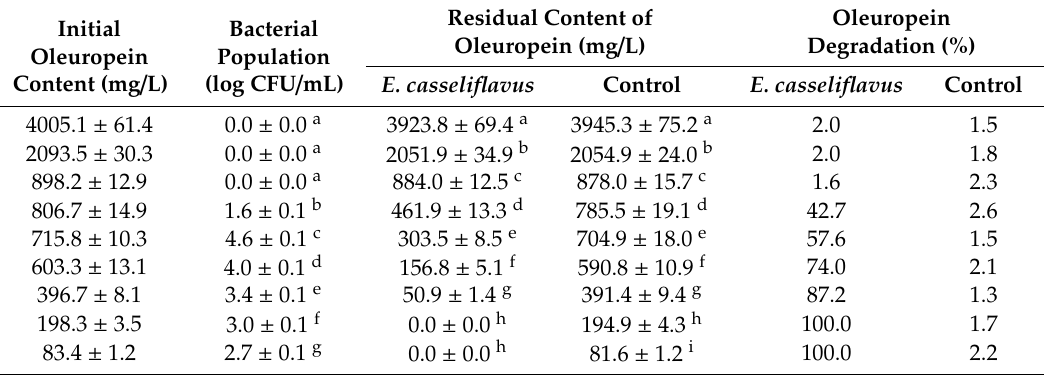
Table 3. Bacterial population and oleuropein degradation percentage after exposure of the Enterococcus casseliflavus isolate on a substrate, containing the polar extract of the olive fruit (without or after appropriate dilutions) and bacterial growth factors (fermentation time: 3